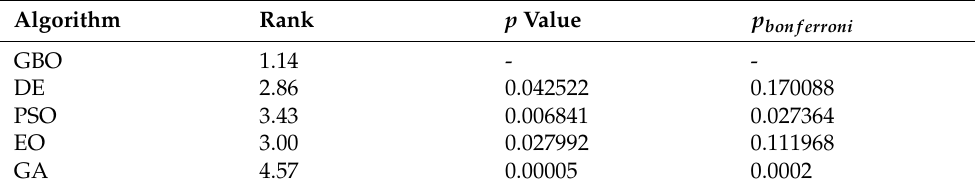
Table 4. Friedman test of the comparison results reported in Table